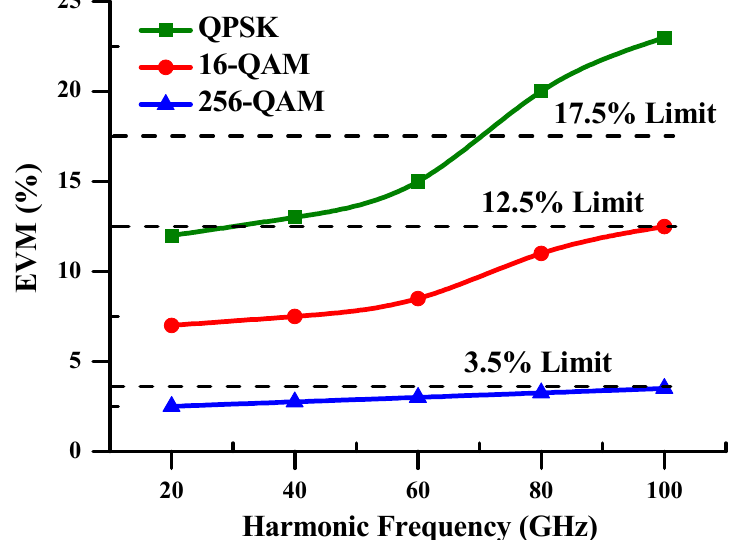
Figure 13. Experimental EVM values versus the harmonic frequency for the “AND” signal at symbol rate of 25 Gbit/s in the case of 4-, 16-, and 256-QAM modulations. QPSK: Quadrature Phase Shift Keying.